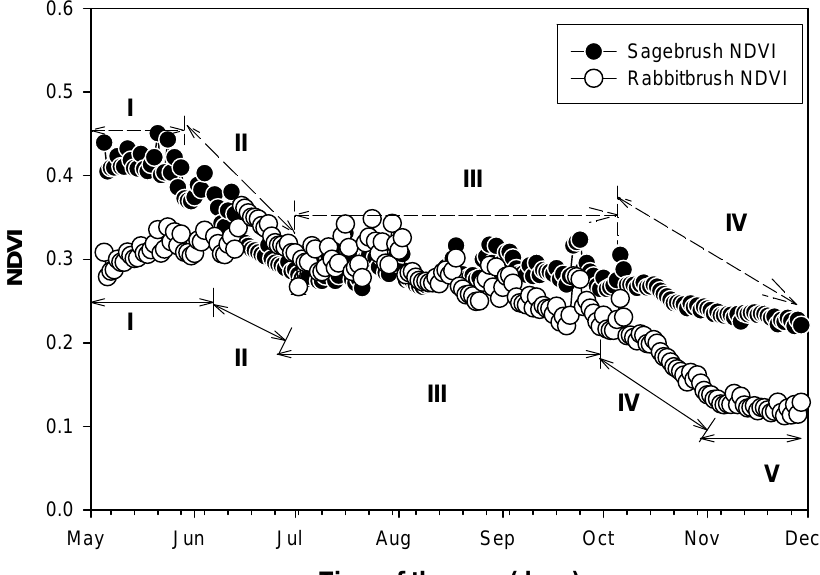
Figure 4. Time series of average midday (11:30-13:30h) NDVI values of a single sagebrush plant and a single rabbitbrush plant at Spring Valley 1 site. Data were